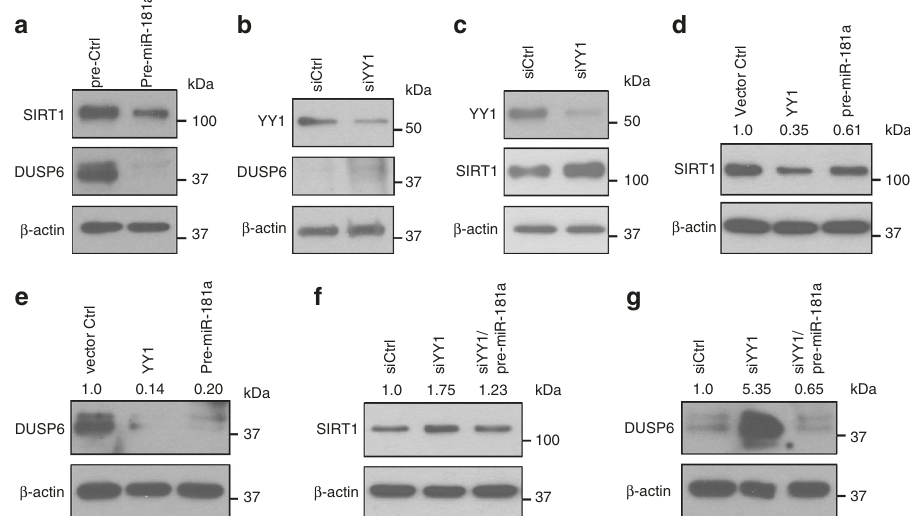
Fig. 4 Loss of YY1 accounts for increased expression of miR-181a targets. a Overexpression of pre-miR-181a down-regulates SIRT1 and DUSP6 expression in CD4 T cells. Immunoblots of SIRT1 and DUSP6 after transfection with pre-miR-181a for 48 h. b , c Knockdown of YY1 enhances the expression of DUSP6 ( b ) and SIRT1 ( c ) in CD4 T cells. Representative immunoblots with YY1 siRNA #1 are shown. d , e SIRT1 ( d ) and DUSP6 expression ( e ) after transfection with YY1 -expressing plasmids and pre-miR-181a. f , g Immunoblot analysis of SIRT1 ( f ) and DUSP6 ( g ) in naïve CD4 T cells transfected with control siRNA, siYY1 alone, or siYY1 combined with pre-miR-181a. All immunoblots are representative of two to three experiments with comparable results for the two YY1